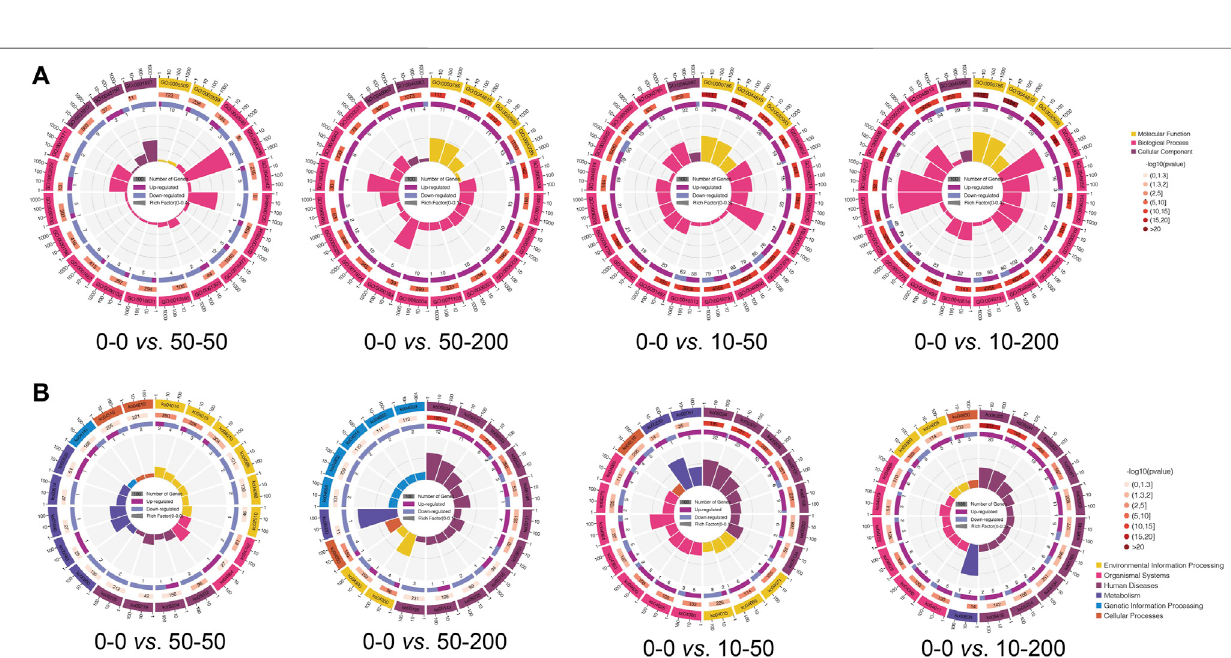
Frontiers in Bioengineering and Biotechnology |